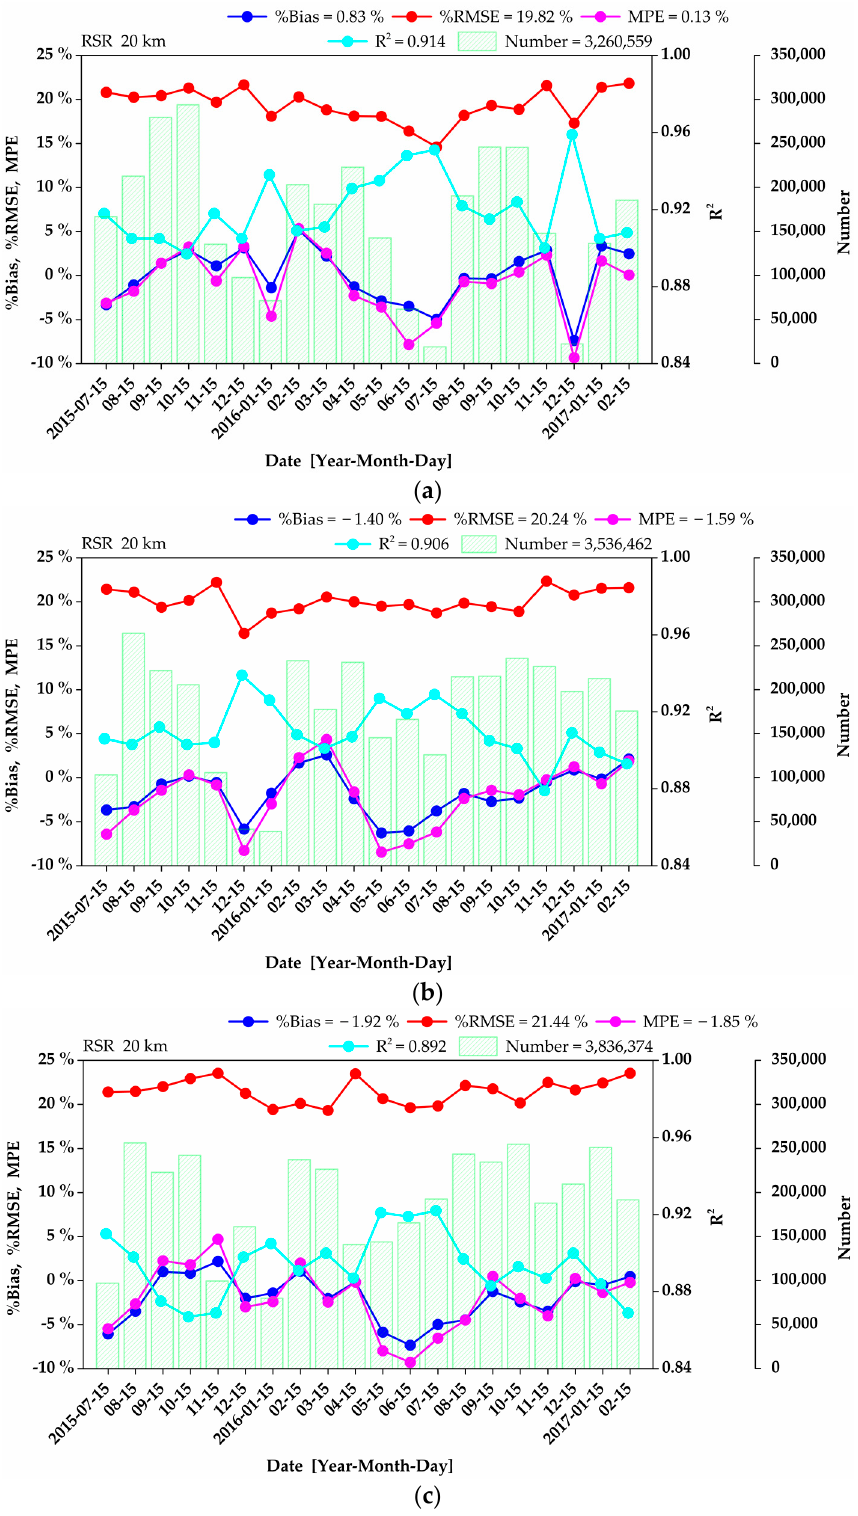
Figure 8. Similar to Figure 6 but for validation data in: Terra ( a ); Aqua ( b ); and S-NPP ( c